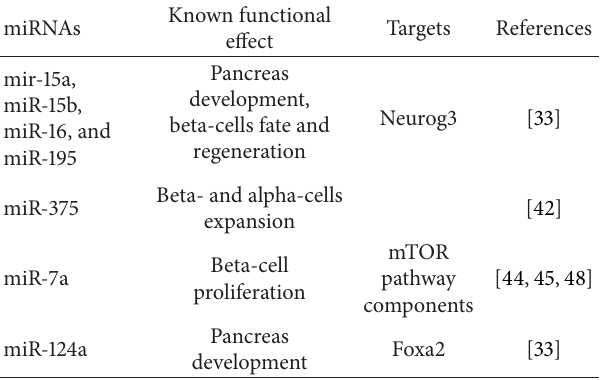
Table 1: miRNAs required for beta cell specification fate and pan- creas